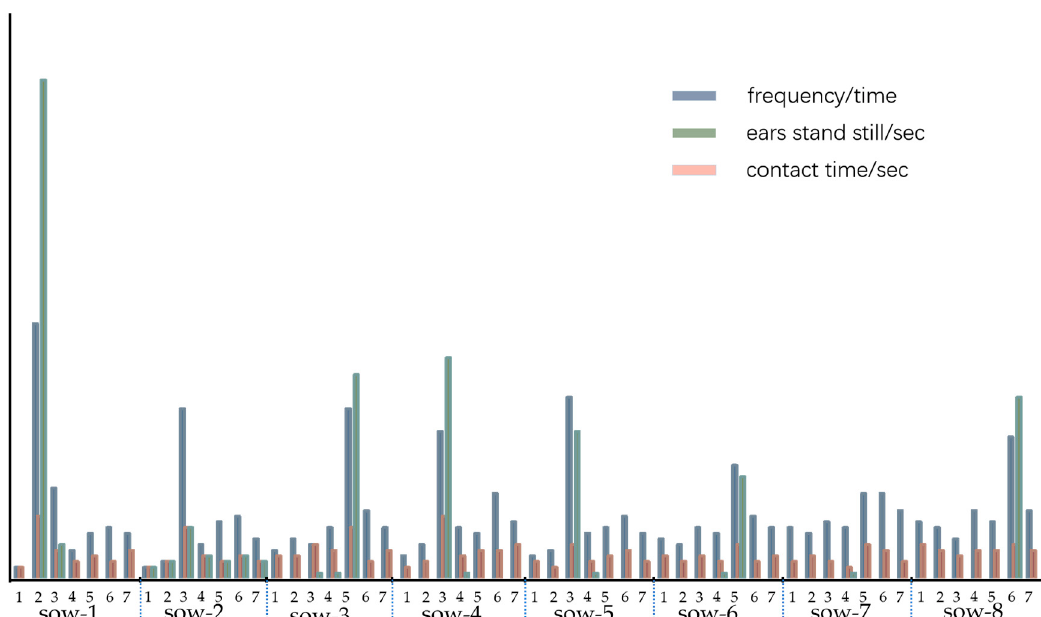
Figure 9. In Figure 9, data columns of different colours on the Y axis represent different units, so they are placed under the same Y axis in order to visually display the data distribution. The response of a sow to the bionic boar (frequency, duration of ears standing still, duration of body standing still). Frequency/time is the number of instances of contact, that is, the frequency of contact per unit time; ears stand still/sec is the static time of both ears of the sow in response to the bionic boar in seconds; contact time/sec is the duration of contact between the sow and the bionic boar in seconds.